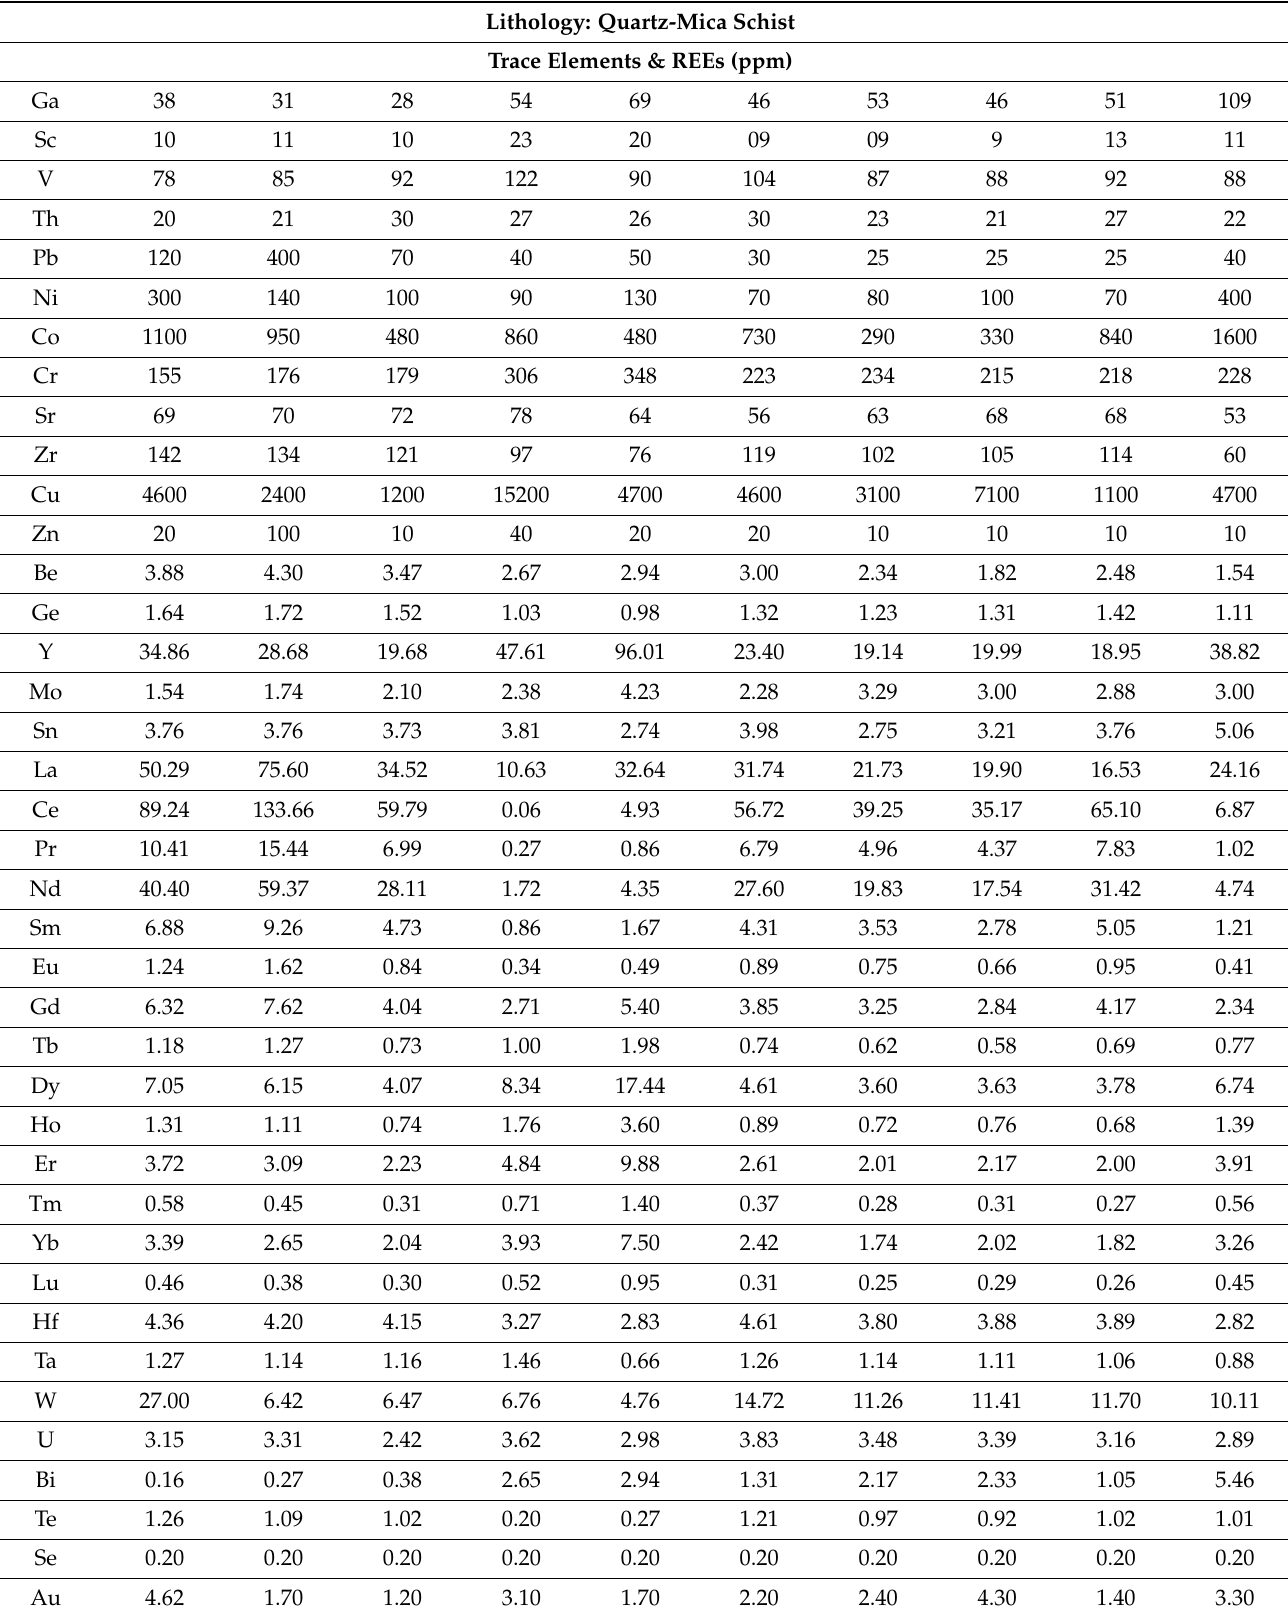
Table 6. Geochemical results of samples from theJagpura